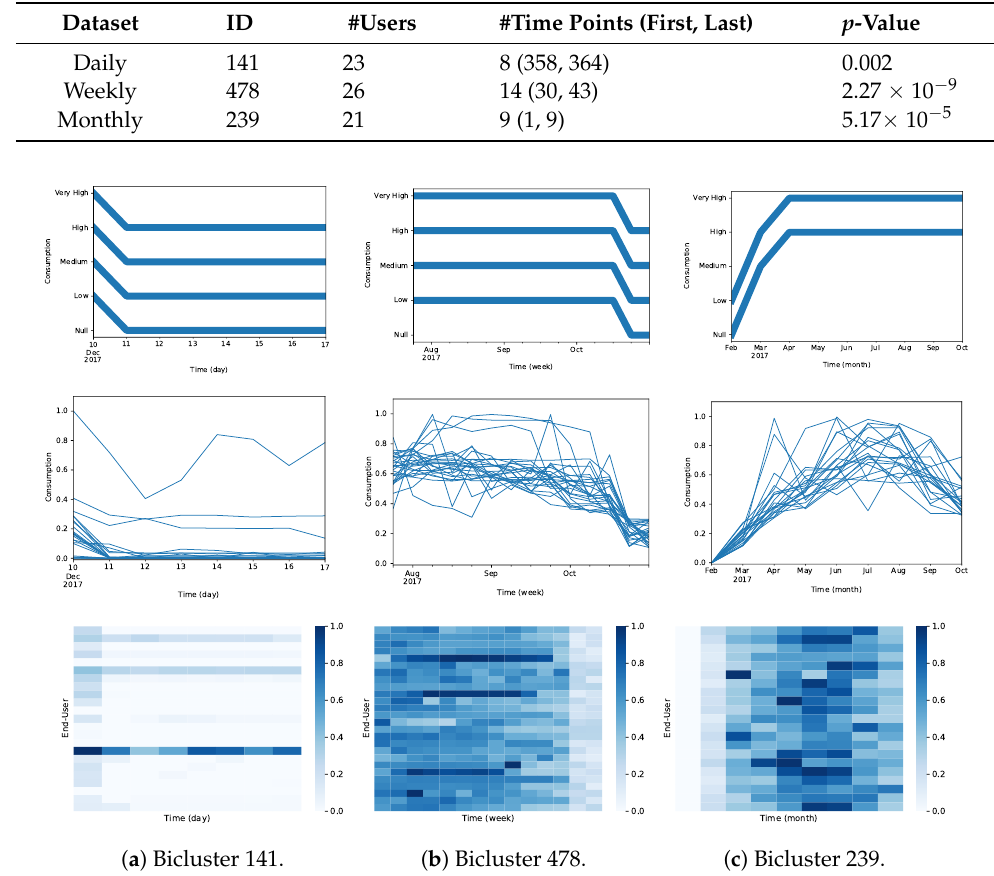
Figure 24. Illustration of the selected biclusters assuming shifting factors (Bicluster 141, Bicluster 478, and Bicluster 239) found on the daily, weekly and monthly dataset. This figure shows the consumption patterns on the first row, the user consumption scaled time series on the second row, and the scaled data heatmap on the third row.